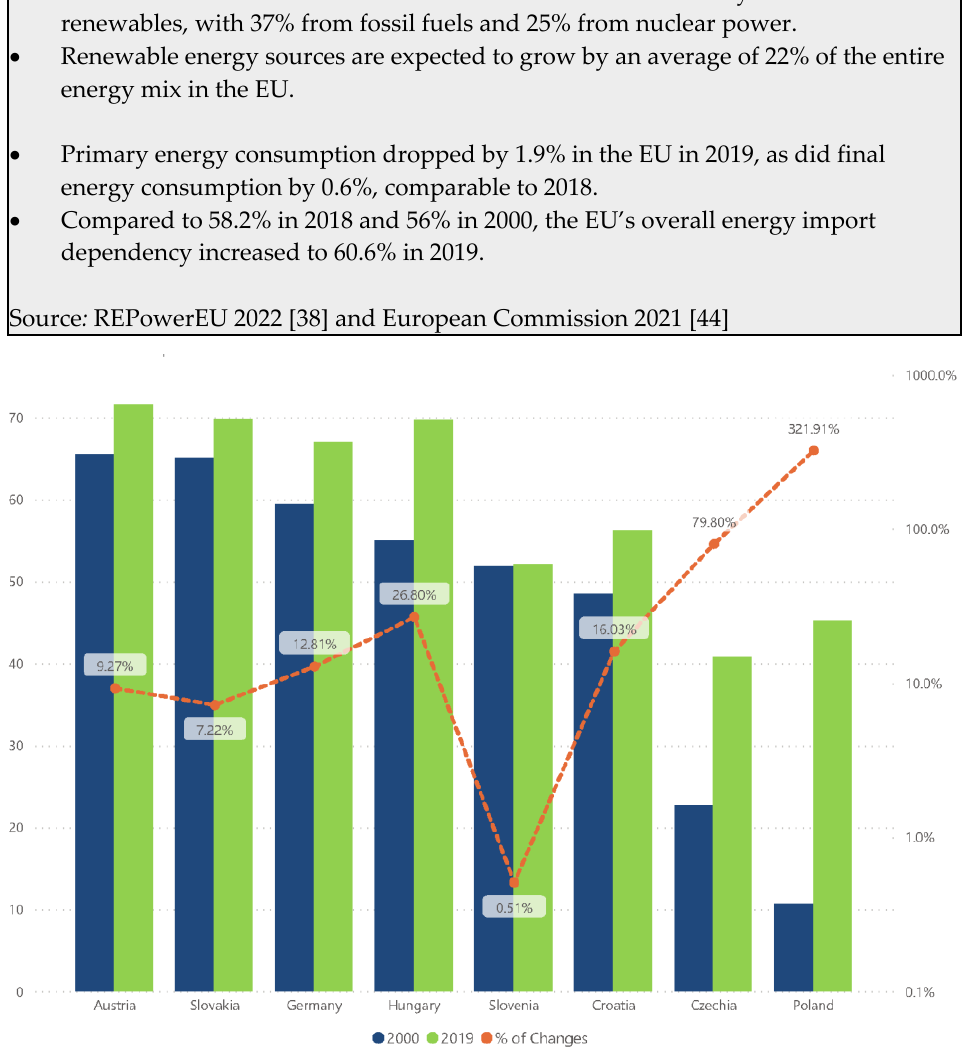
Figure 3. Energy dependency rate (%) of central European countries in 2021. Source: Developed based on Eurostat data, 2019 [43].